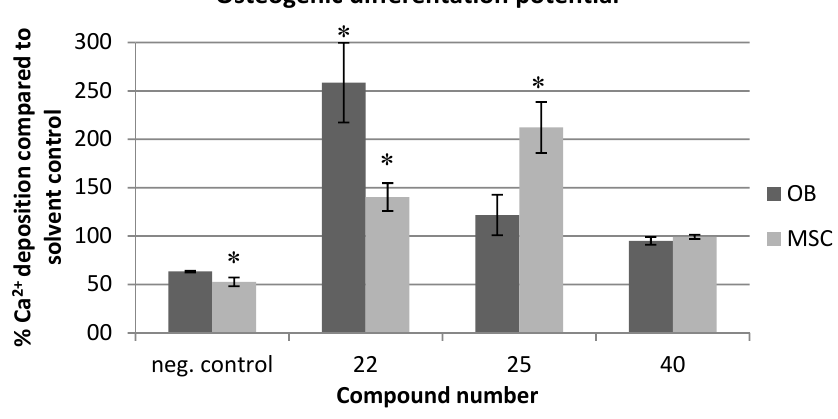
Figure 6. Effect of selected compounds (12.5 µM) on the osteogenic differentiation potential of osteoblasts (OB) and mesenchymal stem cells (MSC) after resp. 3 and 5 weeks of exposure, as determined by measuring the amount of calcium deposition compared to the solvent control. Bars and error bars represent resp. means and standard errors of at least four repeats. The negative control contains no osteogenic supplements. The solvent control contains osteogenic supplements and a 0.5% DMSO background. Significant differences ( p < 0.05) with the solvent control are indicated with an asterix